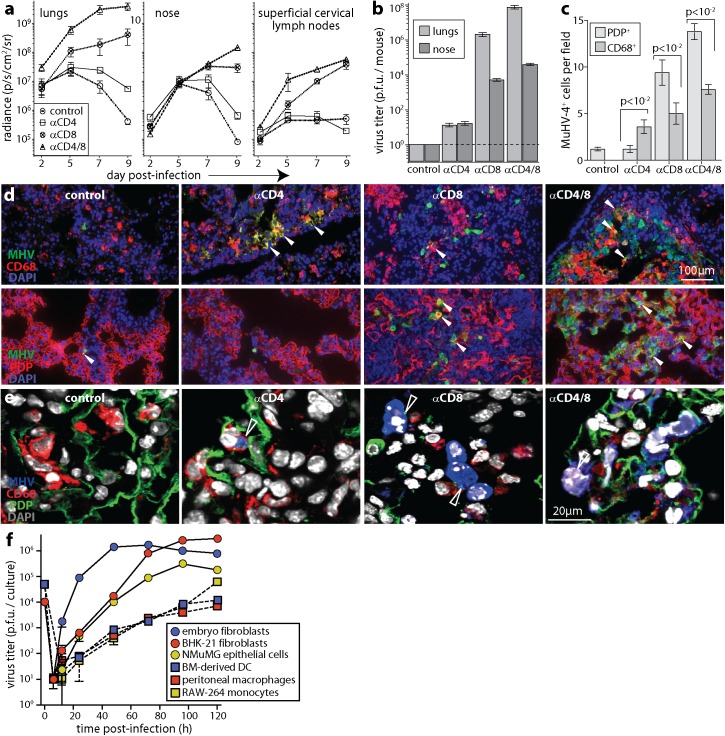
CD8+ T cells control AEC1 infection; CD4+ T cells control AM infection.a. BALB/c mice depleted of CD4+ T cells (αCD4), CD8+ T cells (αCD8), both (αCD4/8) or neither (control) were given MHV-LUC i.n. (104 p.f.u.). Infection was tracked by live imaging of light emission. Mean ± SEM radiance is shown for 6 mice per group. D7 and d9 signals were significantly higher in depleted mice than controls (p<10−2), αCD8 was higher than αCD4 (p<10−2) and αCD4/8 was higher than αCD8 (p<10−3). Noses at d9 showed the same hierarchy (p<10−2). SCLN signals were significantly higher in αCD8 and αCD4/8 mice than controls at d7 and d9 (p<10−3) and significantly lower in αCD4 mice at d9 (p<0.05). b. Lungs and noses of mice as in a were plaque assayed for infectious virus at d9. Bars show mean ± SEM of 6 mice per group. All depletions increased virus titers relative to controls (p<10−4), αCD8 gave a greater increase than αCD4 (p<10−4) and αCD4/8 gave a greater increase than αCD8 (p<10−2). c. BALB/c mice were treated as in a. 9d later lung sections were stained for MHV and CD68 or PDP. Bars = mean ± SEM counts for 3 mice, counting cells across 3 fields of view per section for 3 sections of each mouse. d. Example images from c show infected CD68+ and PDP+ cells. Red / green co-localization appears as yellow. e. Higher magnification, triple-stained images show a CD68+ cell with MHV antigen after anti-CD4, MHV+ cells with residual PDP staining after anti-CD8, and a MHV+CD68+ cell after anti-CD4/8 (arrows). Red+blue co-localization appears as pink; green+blue co-localization appears as cyan. f. NMuMG epithelial cells, BHK-21 fibroblasts and mouse embryo-derived fibroblasts were infected with MuHV-4 at 0.01 p.f.u. / cell; RAW-264 monocytes, peritoneal macrophages and bone marrow-derived dendritic cells were infected at 0.1 p.f.u. / cell. After 4h the cells were washed in pH = 3 buffer to inactivate residual input virions. Infection was then tracked by plaque assay of replicate cultures. Mean ± SD of triplicate cultures are shown. Despite higher inocula, myeloid cells consistently yielded less virus from 24h onwards (p<10−2 by Student’s 2-tailed unpaired t test, comparing myeloid culture titers at each time point with non-myeloid cultures).